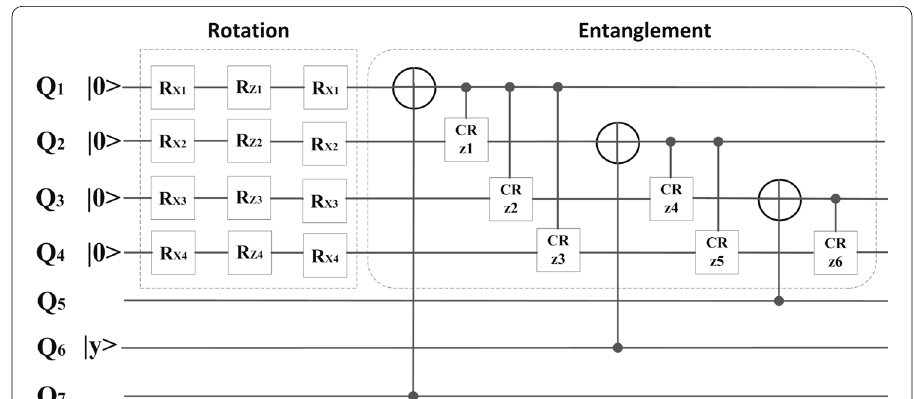
Fig. 7 The quantum generator circuit diagram in this QCGAN experiment